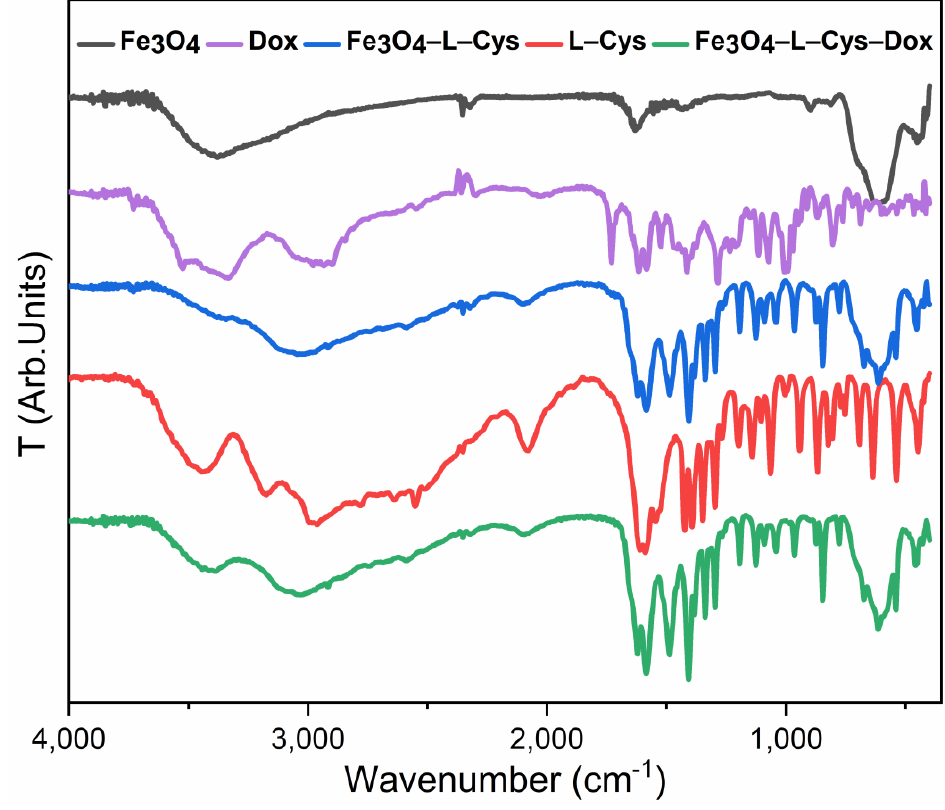
Figure 5. FT-IR spectrum for Fe 3 O 4 , Fe 3 O 4 -L-Cys, Fe 3 O 4 -L-Cys-Dox, Dox and L-Cys.